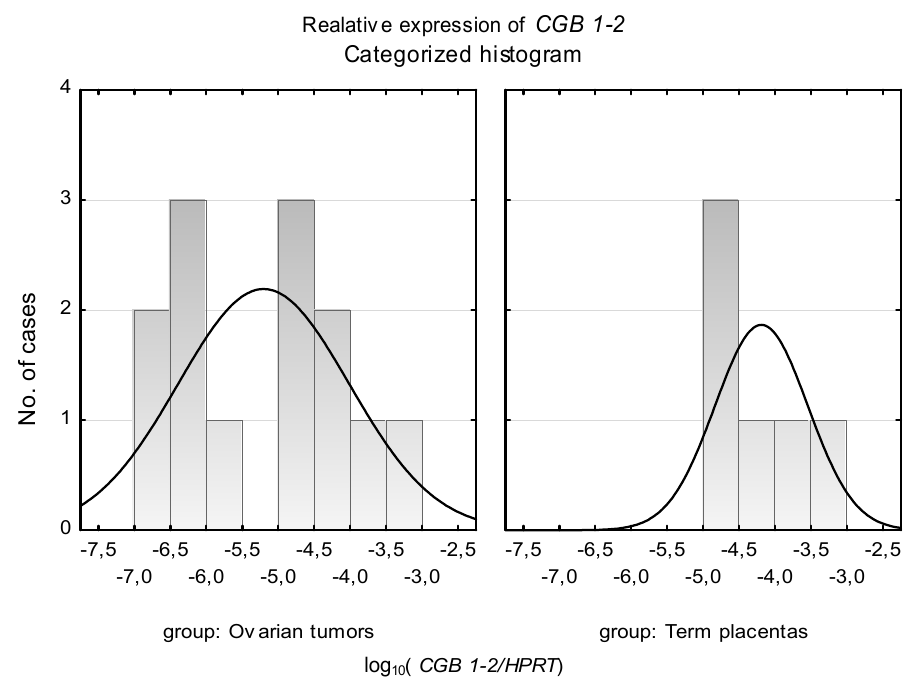
Figure 4. Categorized histogram of CGB1-2 relative expression in tissues of normal ovaries, ovarian carcinomas and term placentas. Results are presented as the logarithm to the base 10. Data not normally